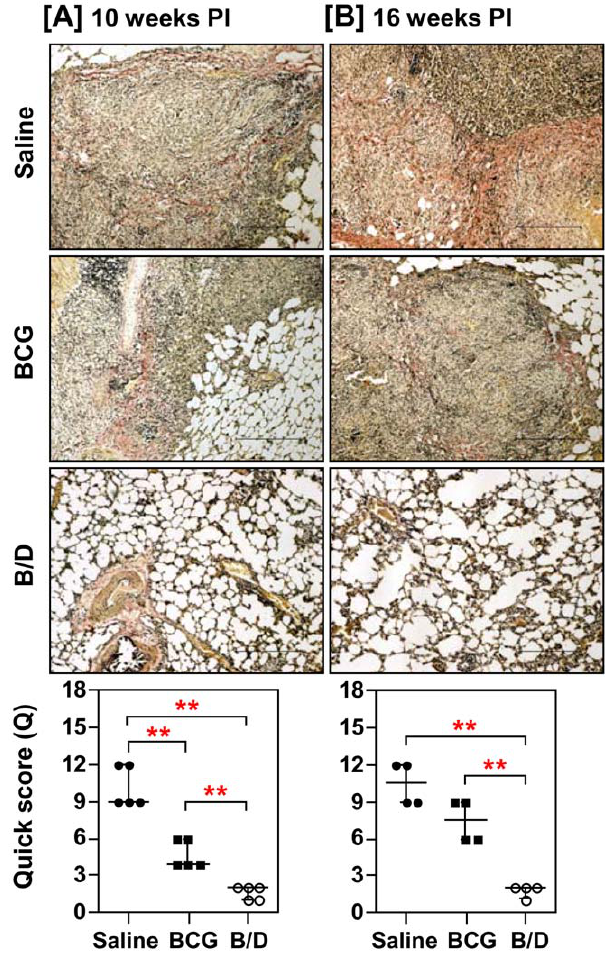
Figure 4. Influence of vaccination on the antigen load in pulmonary granulomas post-infection. The representative photo- micrographs (10 6 ) of 5 m m lung sections showing immuno-histochem- ical staining (brown color) for Ag85 complex proteins in pulmonary granulomas at (A) 10 weeks (Exp-I, n=5) and (B) 16 weeks (Exp-II, n=4) post-infection. Unvaccinated animals exhibited extensive staining surrounding and within the granulomatous areas; BCG vaccinated animals exhibited a moderate antigen staining and B/D vaccinated animals exhibited no evident sign of antigen staining in conjunction with negligible granulomatous inflammation. Scale bar represents 1 mm. Extent (Q) of staining was measured [Quick score (Q)=intensity (I) X area (A) of staining] and represented graphically as median ( 6 inter quartile range). *, p , 0.05 and **, p , 0.01 (Mann-Whitney U test).